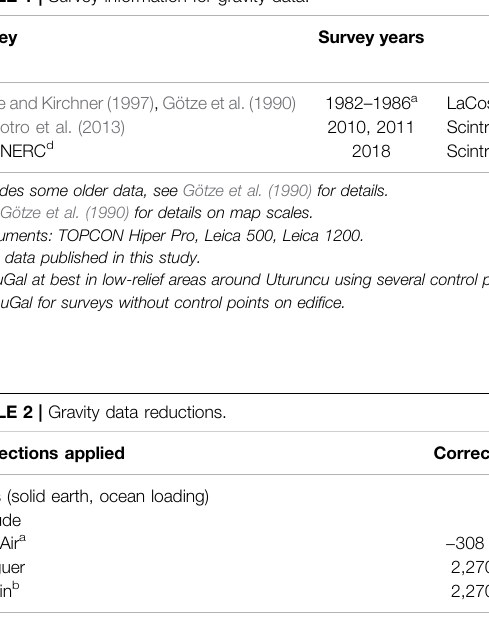
TABLE 1 | Survey information for gravity data.